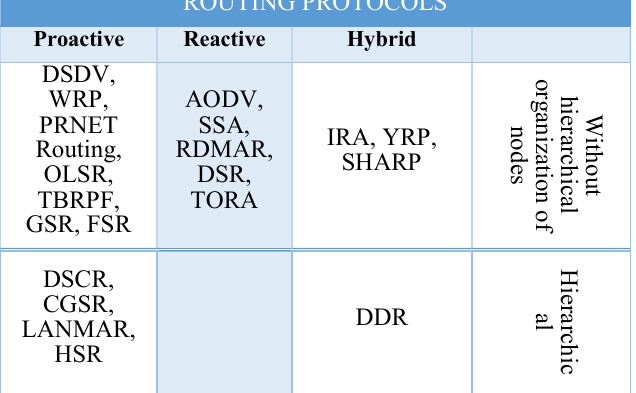
Table 1. Routing protocols in mobile ad hoc